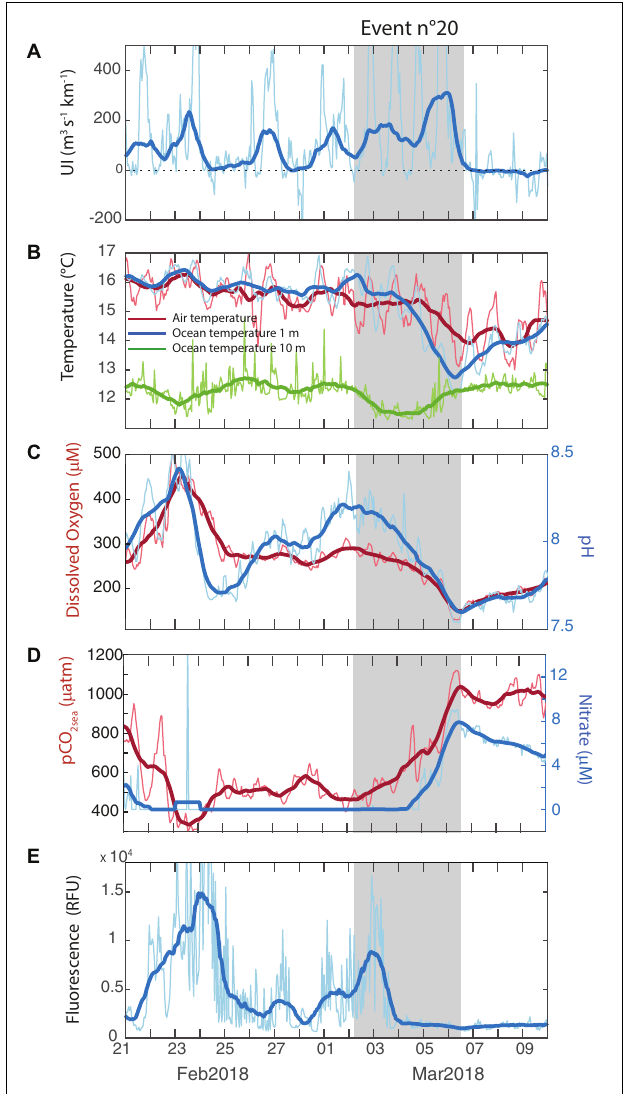
FIGURE 6 | Close-up to an upwelling event that began on March 02, 2018 (event number 20). (A) Upwelling Index, (B) Air temperature ( ◦ C, red line), ocean temperature at 1 m depth (blue line) and ocean temperature at 10 m depth (green line), (D) p CO 2 sea ( µ atm, red line) and Nitrate ( µ M, blue line), (C) Dissolved Oxygen ( µ M, red line) and pH (blue line) and (E) Fluorescence (RFU).